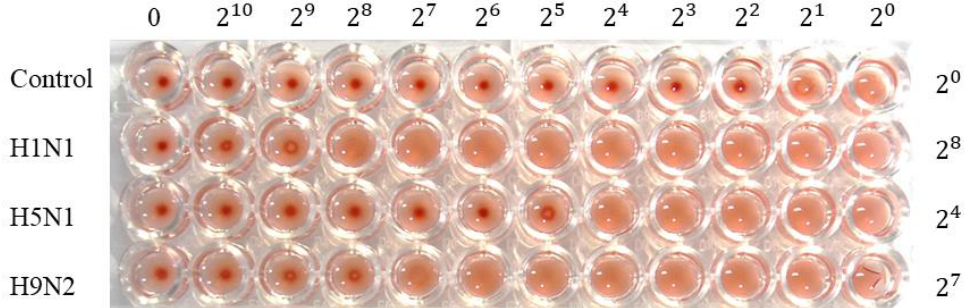
Figure 4. Hemagglutination assay for influenza virus. HA titers were H1N1 = 256 HAU, H5N1 = 16 HAU, and H9N2 = 128 HAU.